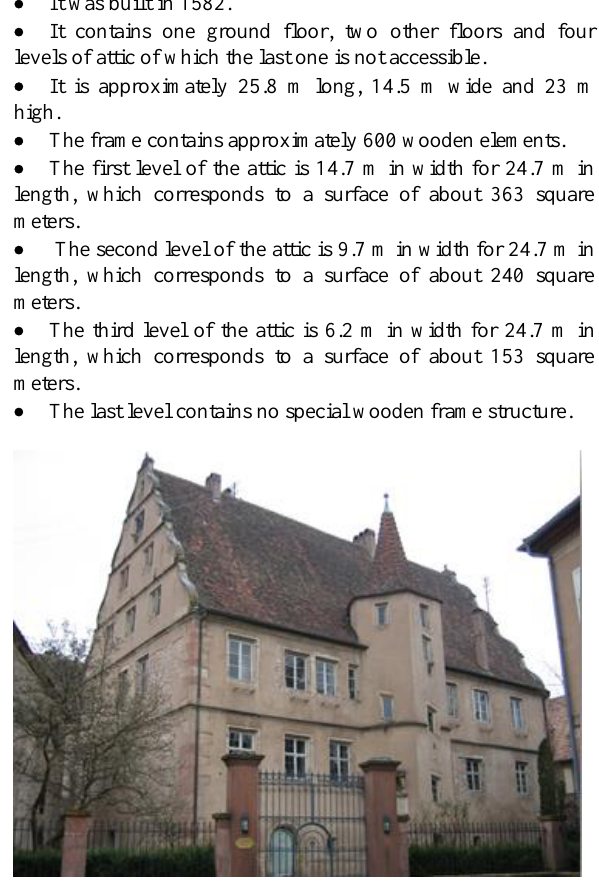
Figure 2.a: “Seigniory”